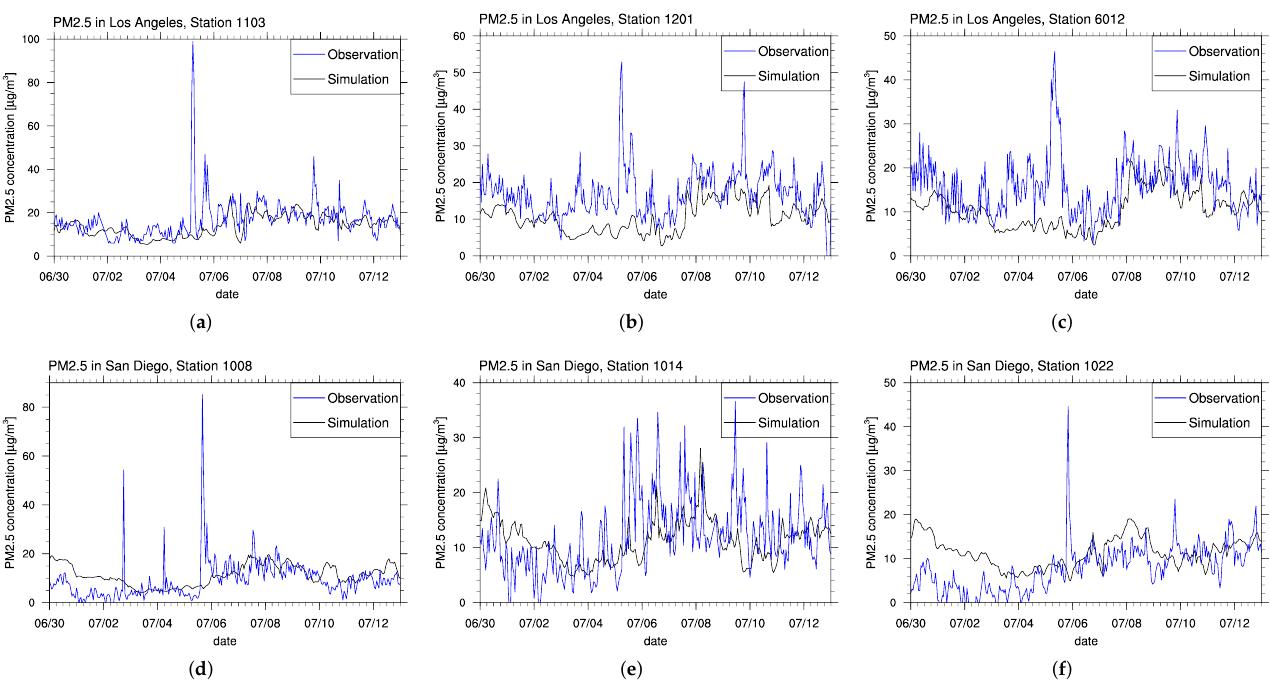
Figure 15. Comparison of in situ measurements with modeled PM2.5 at the ground at Los Angeles North Main Street ( a ), Reseda ( b ), Santa Clarita ( c ), Camp Pendleton ( d ), Donovan ( e ), and El Cajon, Lexington Elementary School ( f ) in July 2018.